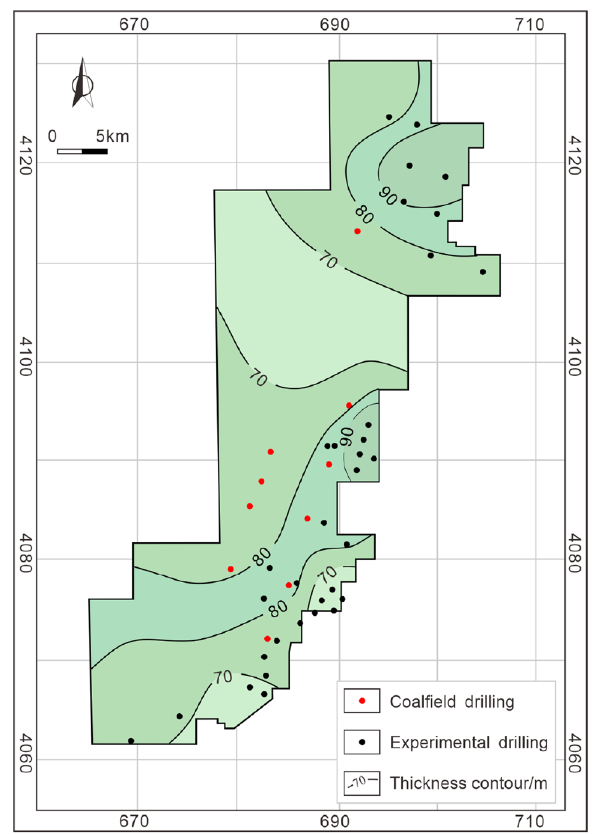
Figure 5. Cumulative thickness contour of mudstone in the Taiyuan